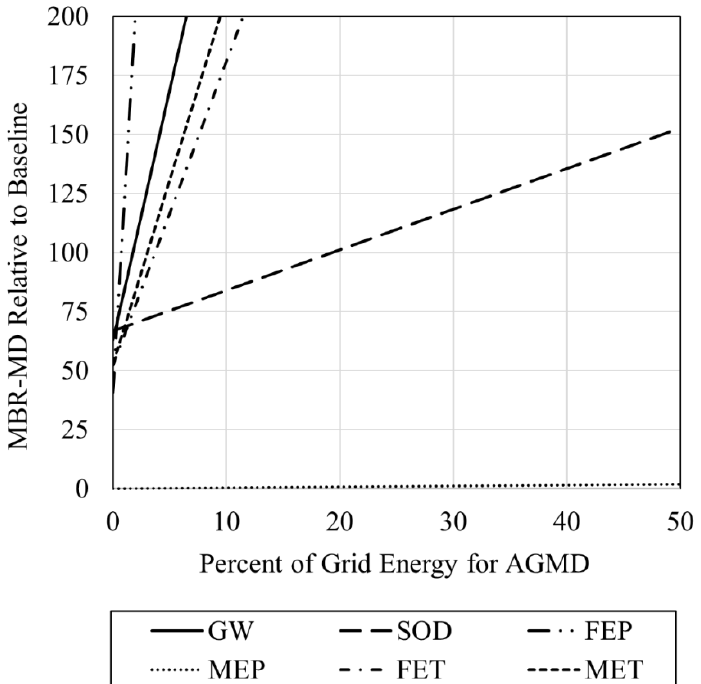
Figure 6. MBR-MD environmental impacts relative to the Baseline at varying MD grid energy percentages for the GW, SOD, FEP, MEP, FET, and MET impact categories.